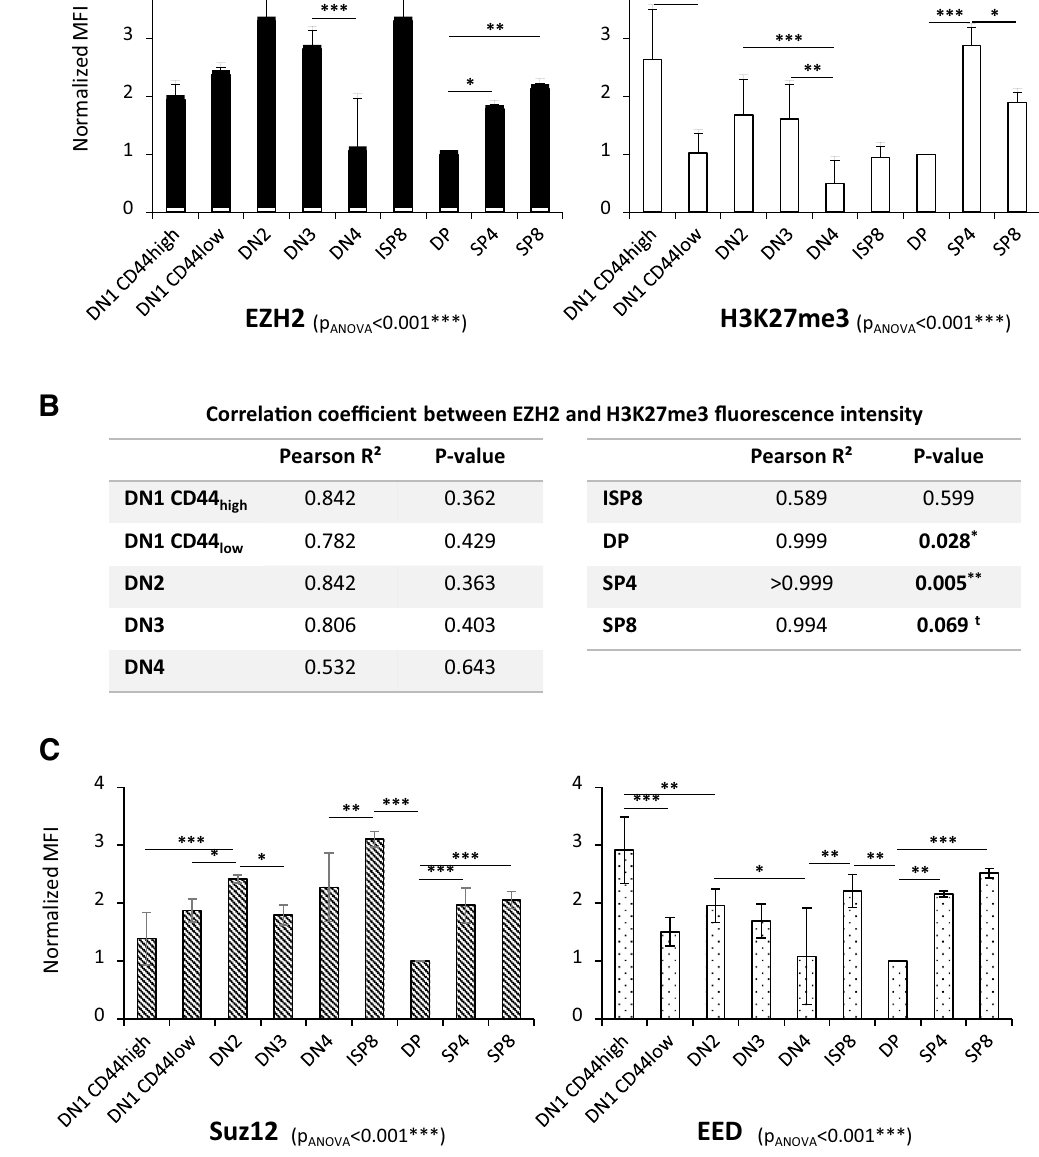
Figure 2. The EZH2 expression level is tightly regulated during T lymphopoiesis and is not correlated with H3K27 trimethylation. EZH2, H3K27me3, EED and Suz12 levels were evaluated at each stages of T lymphopoiesis by flow cytometry. ( A ) EZH2 (left panel) and H3K27me3 (right panel) median fluorescence intensity (MFI) variation during T lymphopoiesis. The MFI for each subpopulation was normalized to the MFI of DP. Data are mean ± SD of 3 independent experiments. ANOVA tests were performed followed by post hoc PLSD Fisher tests. * P < 0.05, ** P < 0.01, *** P < 0.001. ( B ) Absence of correlation between EZH2 and H3K27me3 levels in double-negative stages and ISP8 stage. For each stage, the median EZH2 fluorescence was plotted against the median H3K27me3 fluorescence. The Pearson correlation coefficient (Pearson R 2 ) was calculated, and the bilateral Pearson test was performed and is indicated in the table. t P < 0.07*, P < 0.05, ** P < 0.01. ( C ) Suz12 (left panel) and EED (right panel) MFI variation during T lymphopoiesis. The MFI for each subpopulation was normalized to the MFI of DP. Data are mean ± SD of 3 independent experiments. ANOVA tests were performed followed by post hoc PLSD Fisher tests. * P < 0.05, ** P < 0.01, *** P <